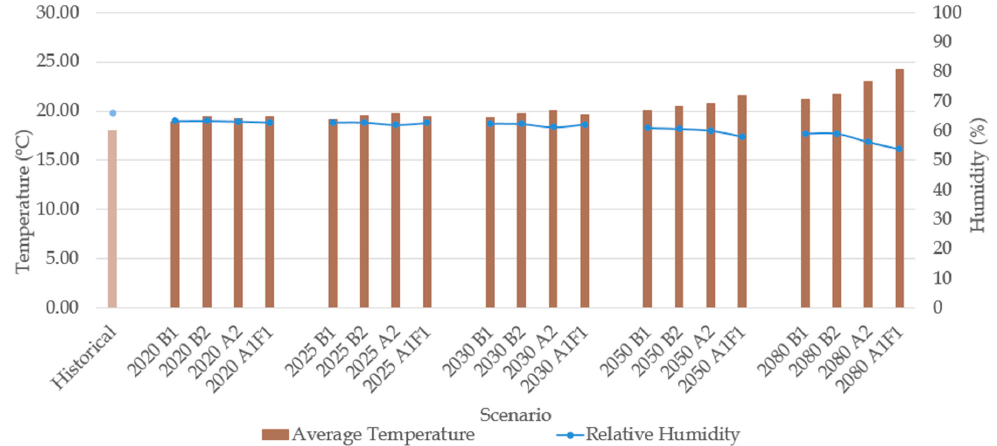
Figure 5. Variation of average temperature and relative humidity in historical, present, and future scenarios and sub-scenarios.